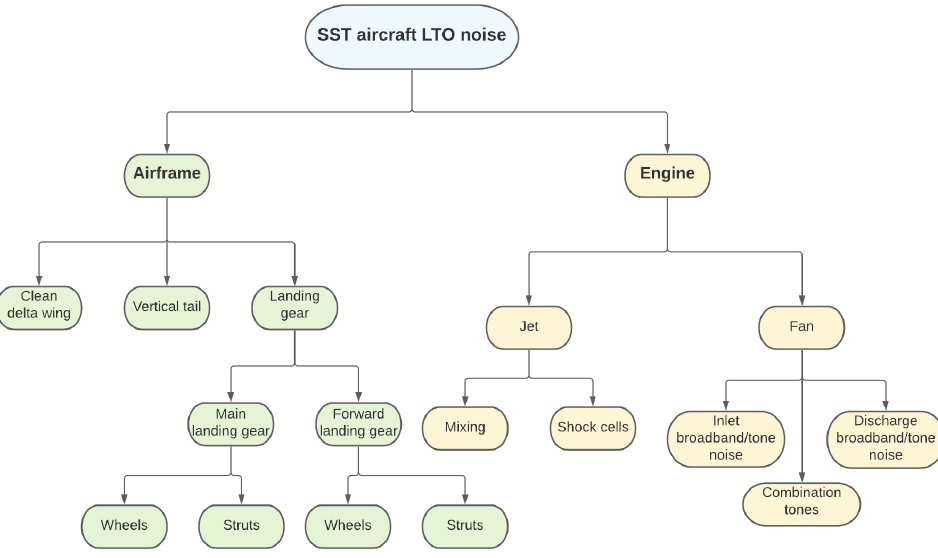
Figure 3. SST aircraft LTO noise sources